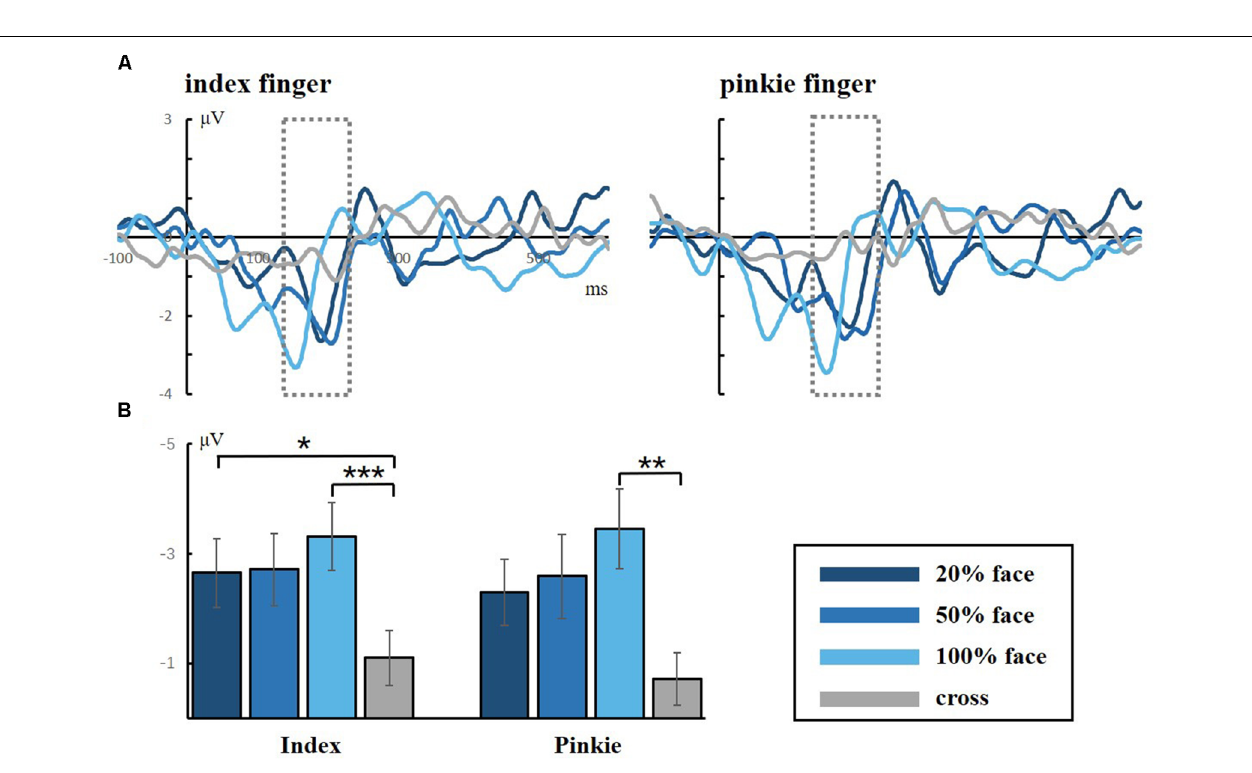
little finger: F (3,36) = 13.134, p < 0.001). For the latency